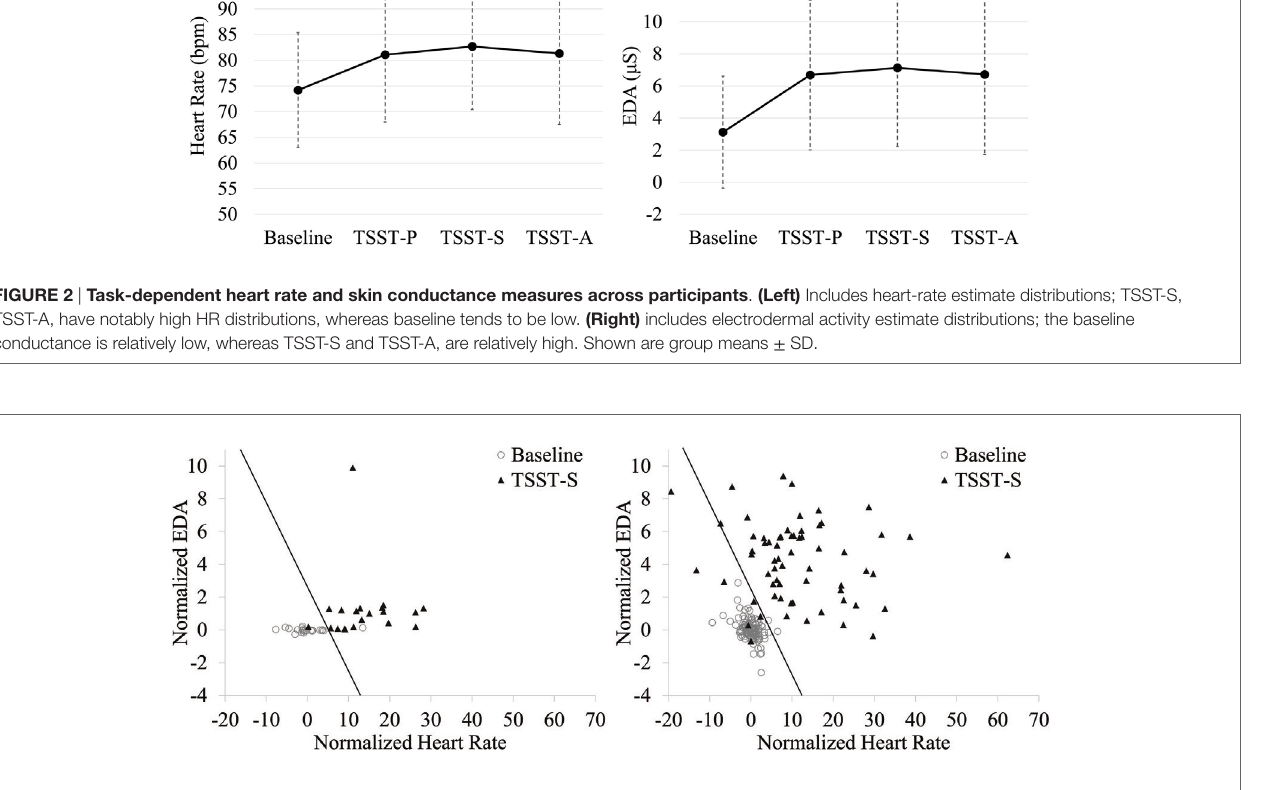
FigUre 3 | stress vs. non-stress classifier using baseline-normalized hr and eDa features during the baseline and TssT-s segments . Stress classification using the E3-collected data is shown at left and with the Biopac-collected data shown at right. The decision boundary is shown as a line; data points to the left of this boundary were classified as non-stress.